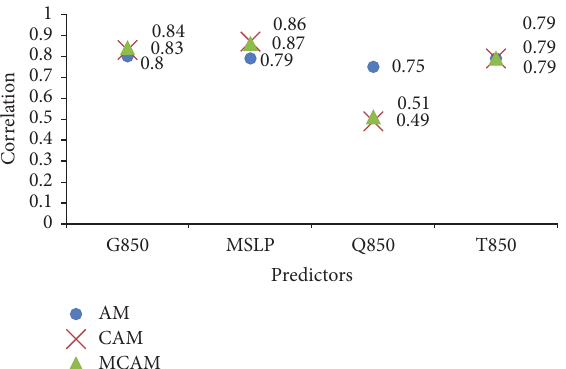
Figure 9: The histogram of the correlation between observations and simulations for four predictors, represented by mean sea level pressure, temperature, moisture, and geopotential height at 850 hPa of the AM, the CAM, and the MCAM decomposition. Table 5: Correlation between the observed rainfall and the predictors using AM and CAM taking into account the atmospheric